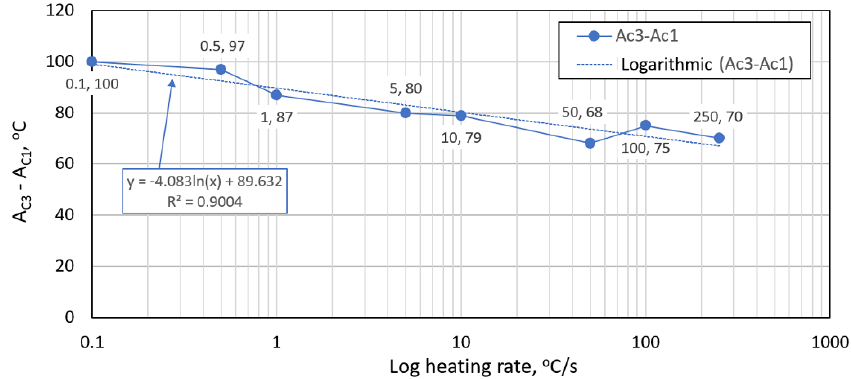
Figure 8. The influence of the heating rate on temperature differences between A c3 and A